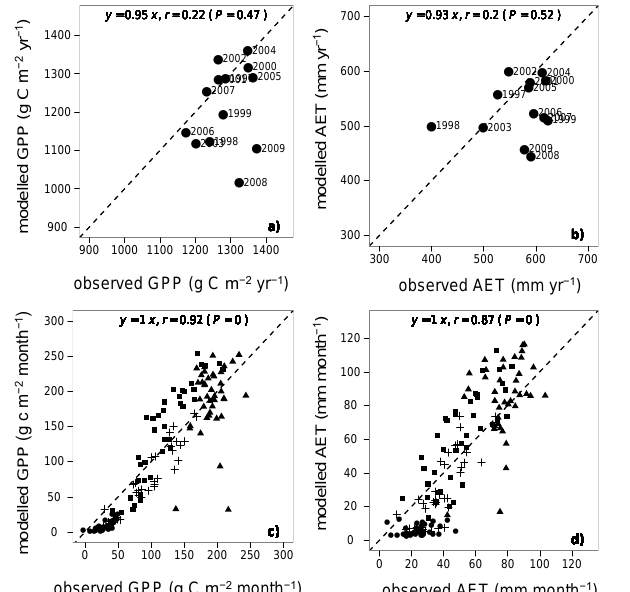
Figure 2. Observed vs. modelled variability in GPP (a, c) and AET (b, d) for the default model scenario (S1) on annual (a, b) and monthly timescales (c, d) . Dotted line is the 1 : 1 line. The equation shows linear regression through the origin, with correlation coef- ficients. Fluxes are hatched per season for sub-panels (c) and (d) : black circles are for winter (December, January, February); black squares are for spring (March, April, May); black triangles are for summer (June, July, August); + = autumn (September, October,